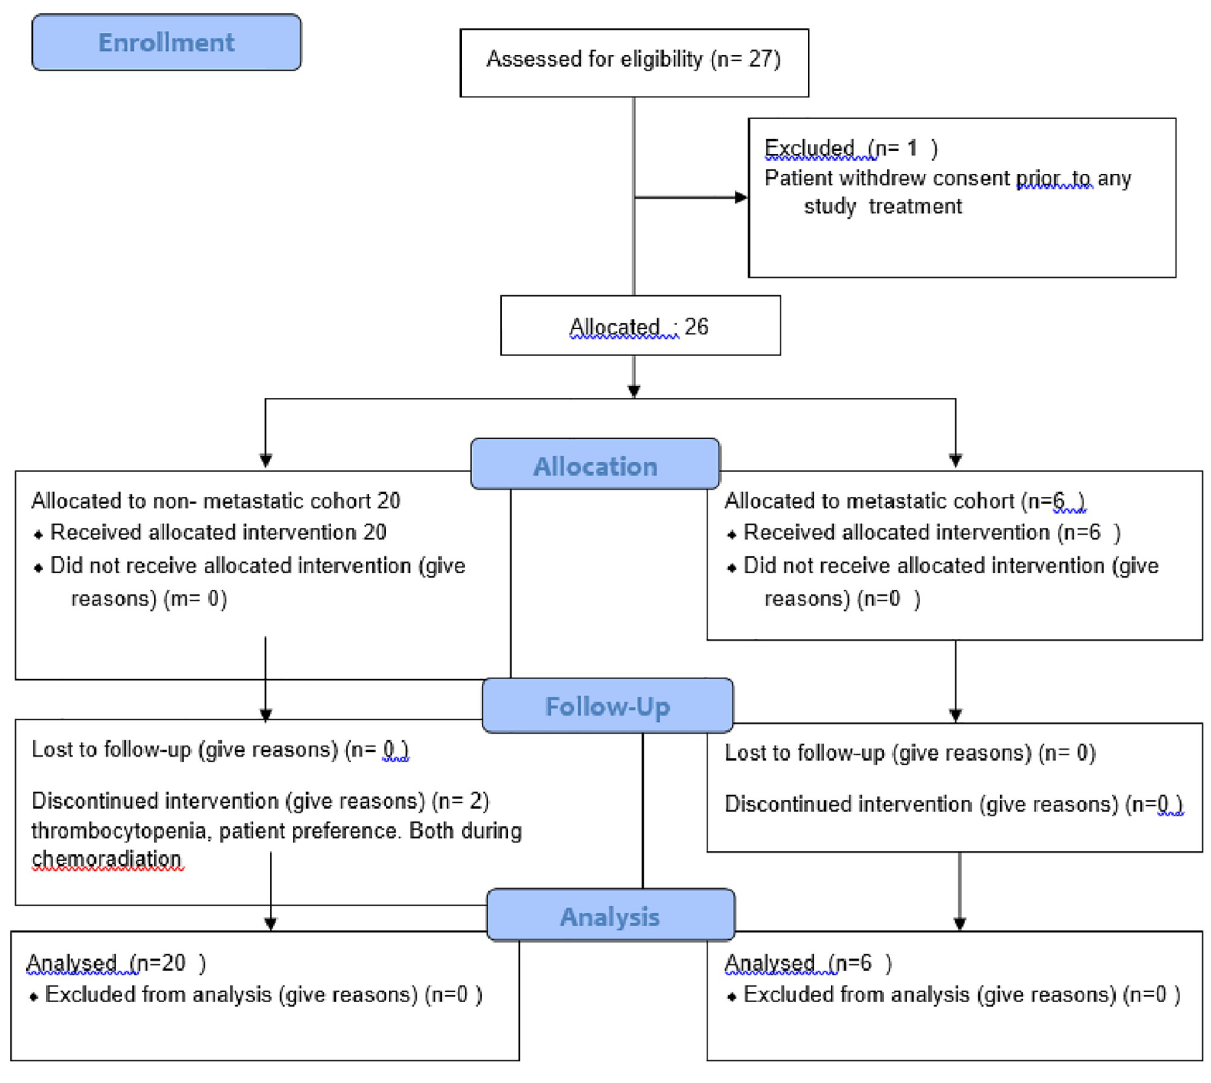
Fig 1. Consort diagram for trial